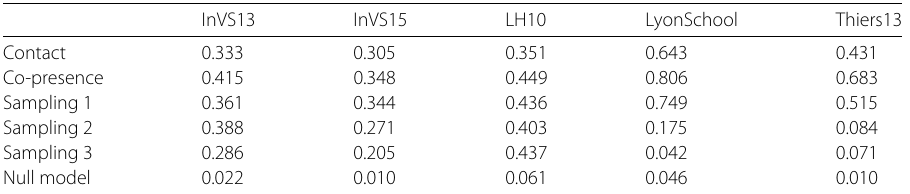
Table 4 Average similarity between daily networks InVS13 InVS15 LH10 LyonSchool Thiers13 Contact 0.333